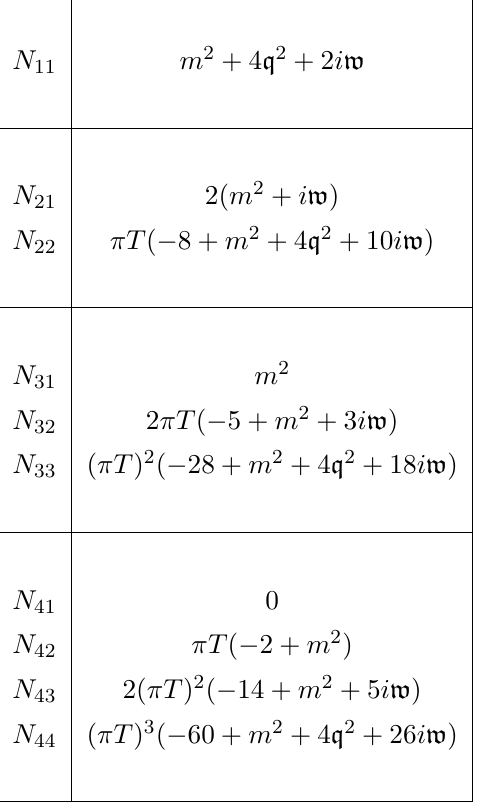
Table 2 . Examples of coefficients for the equations of motion for the vector bulk field expanded near the